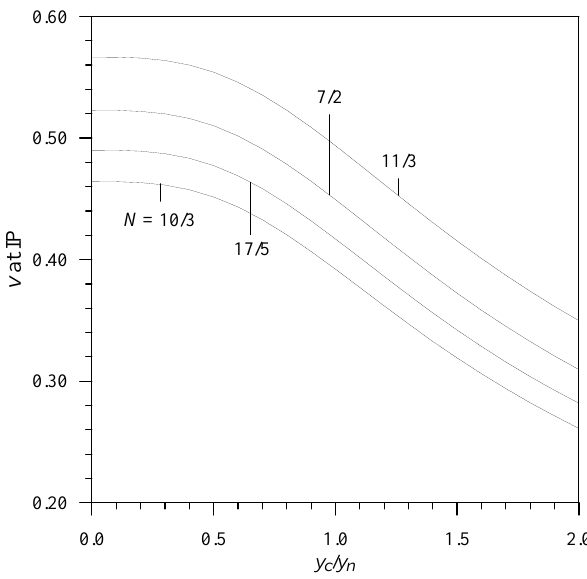
Fig. 4. Plot of four solution curves, each representing the sin-